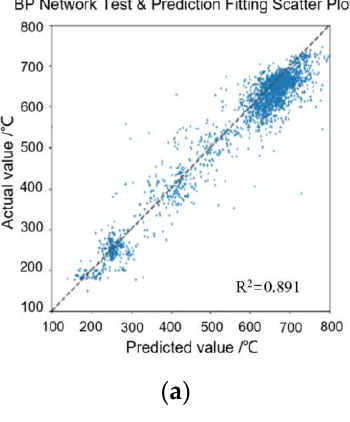
Figure 6. ( a ) Confusion matrix between the predicted value and actual value of BP neural network in the test set; ( b ) confusion matrix between the predicted value and actual value of convolutional neural network in the test set; ( c ) confusion matrix between the predicted value and actual value of multi-scale convolutional neural network in the test set.